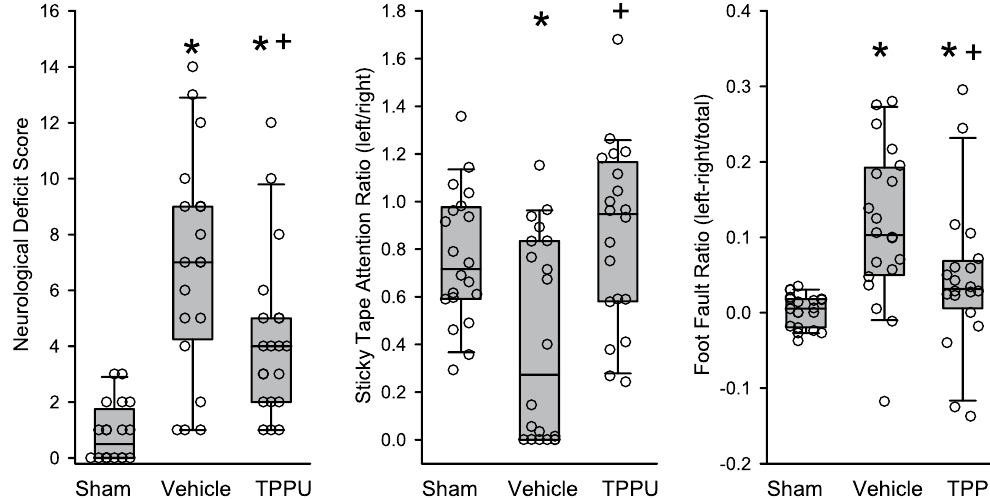
Figure 4. TPPU improves neurologic function at 2 days after MCAO. After right MCAO, ( A ) the neurologic deficit score was less in the TPPU group than in the vehicle group, ( B ) TPPU restored the time ratio of the contralateral left forelimb attention/right forelimb attention in the modified sticky tape test, and ( C ) TPPU decreased the foot-fault index ([left limb faults − right limb faults]/total foot faults). Individual data are shown along with box-whisker plots of the median and the 5, 25, 75, and 95% ranges. The Kruskal-Wallis analysis of ranks test indicated significant treatment effects for all measurements and pairwise comparisons were made with the Mann-Whitney test ( n = 20 rats per group; * p < 0.05 vs. sham; + p < 0.05 vs.